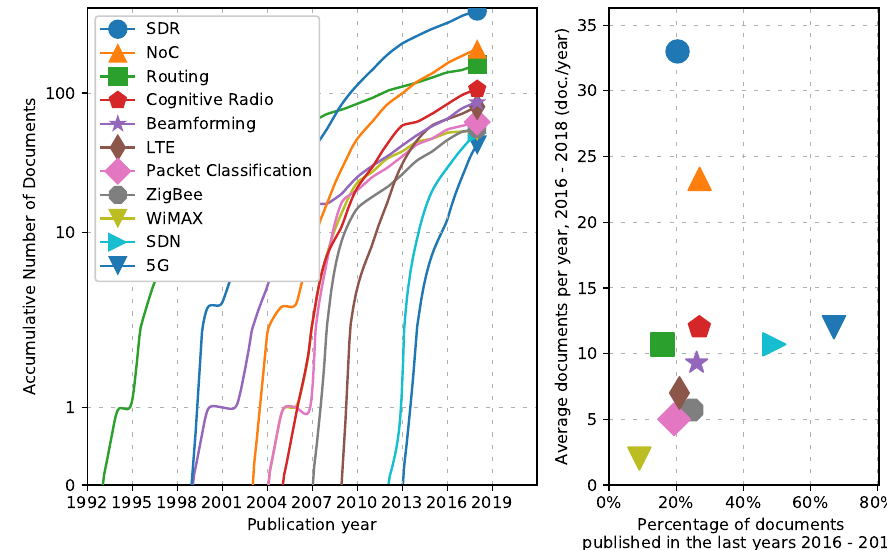
Figure 6. Networking top implementations in FPGA